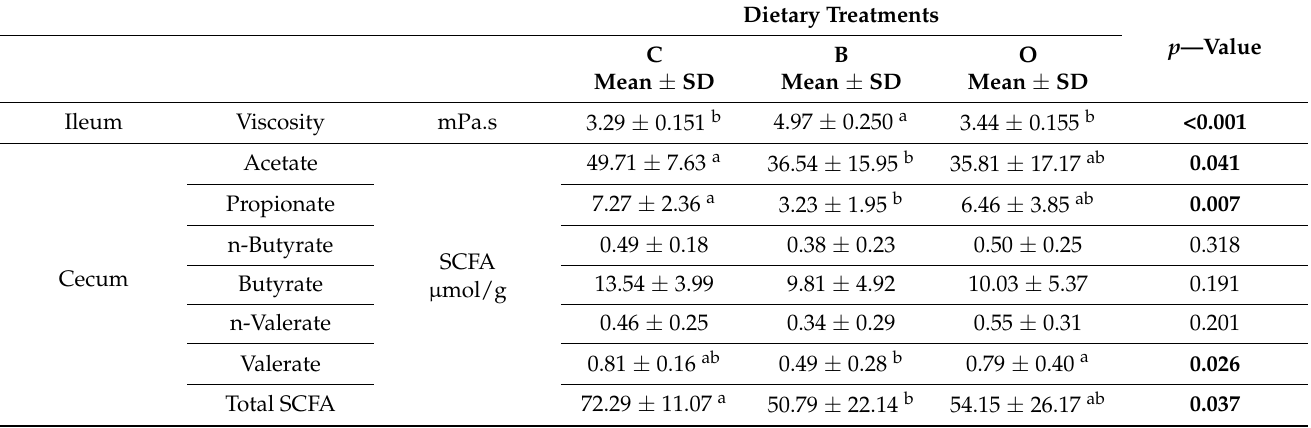
Table 4. Effects of dietary treatments on ileal viscosity and cecal short-chain fatty acid concentrations.